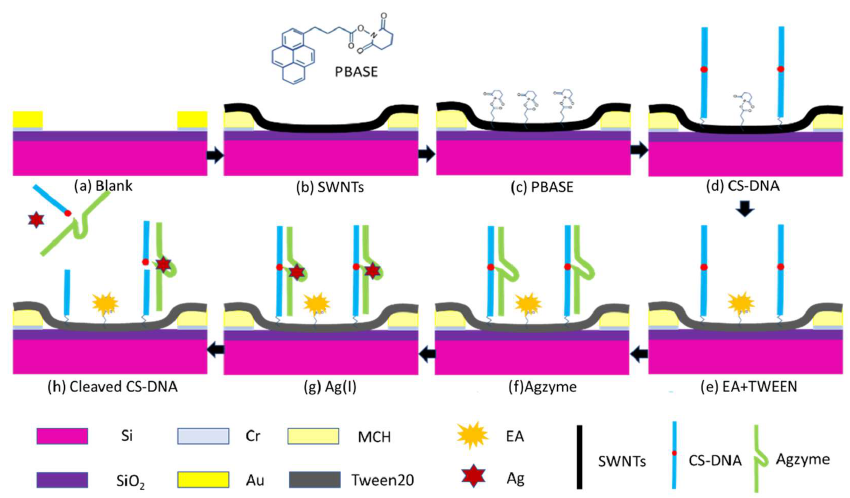
Figure 2. Schematic illustration of SWNT-based biosensor surface functionalization with different materials (SWNTs, MCH, PBASE, CS-DNA, EA, TWEEN20, and Agzyme) and Ag(I) is used to induce cleavage of the DNAzyme.